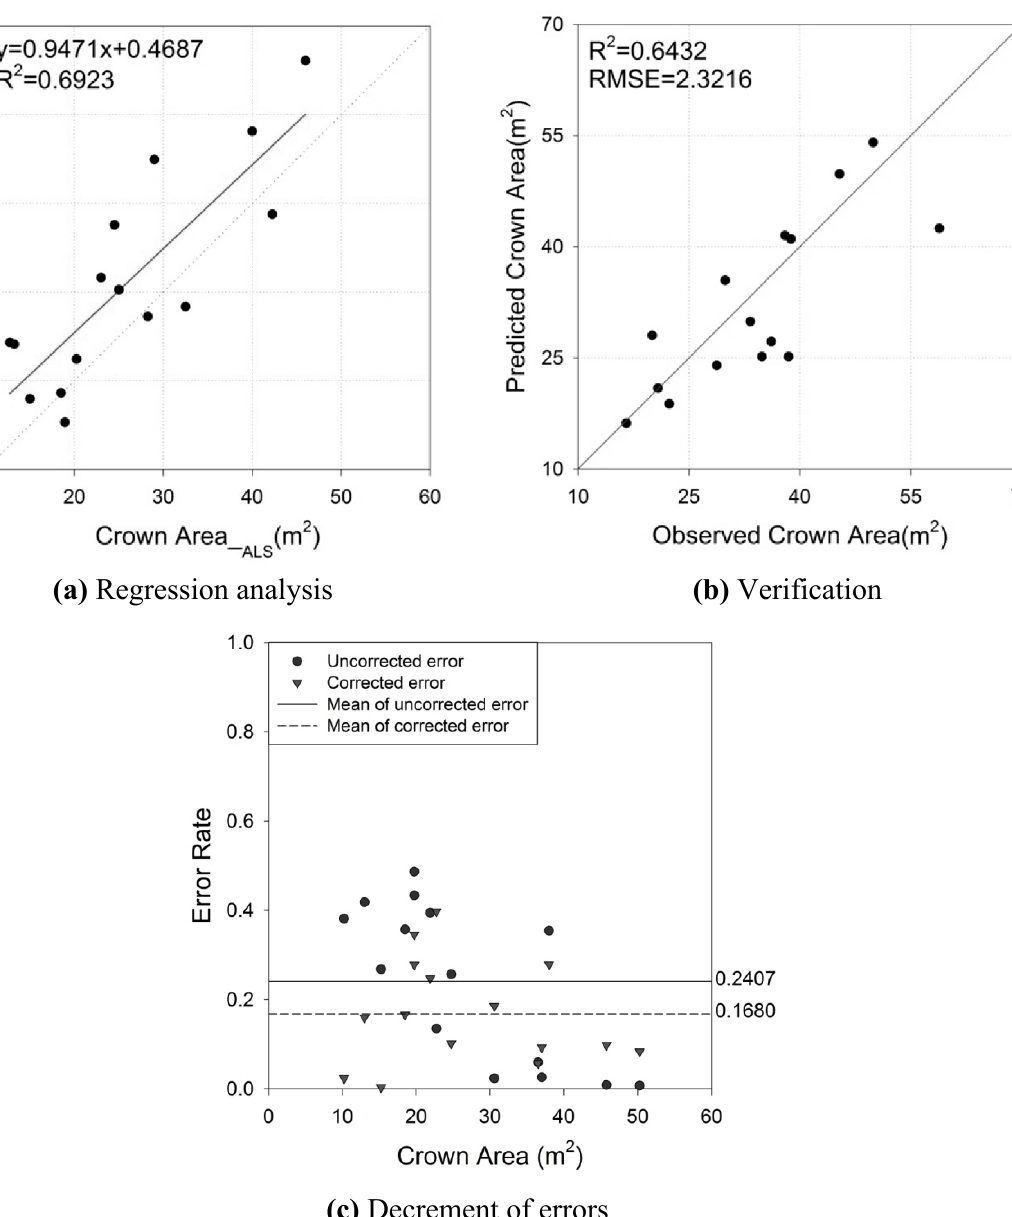
Figure 8. Reduction of CA-estimate errors through the regression